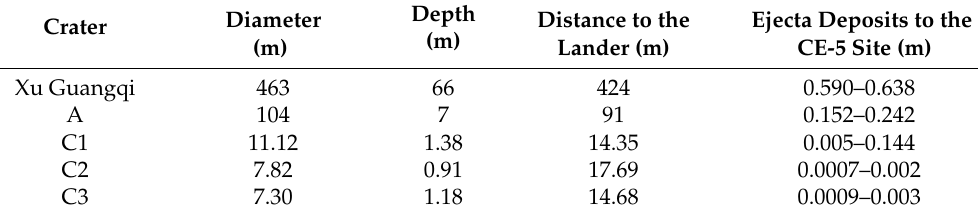
Depth Distance to the (m) Lander (m)